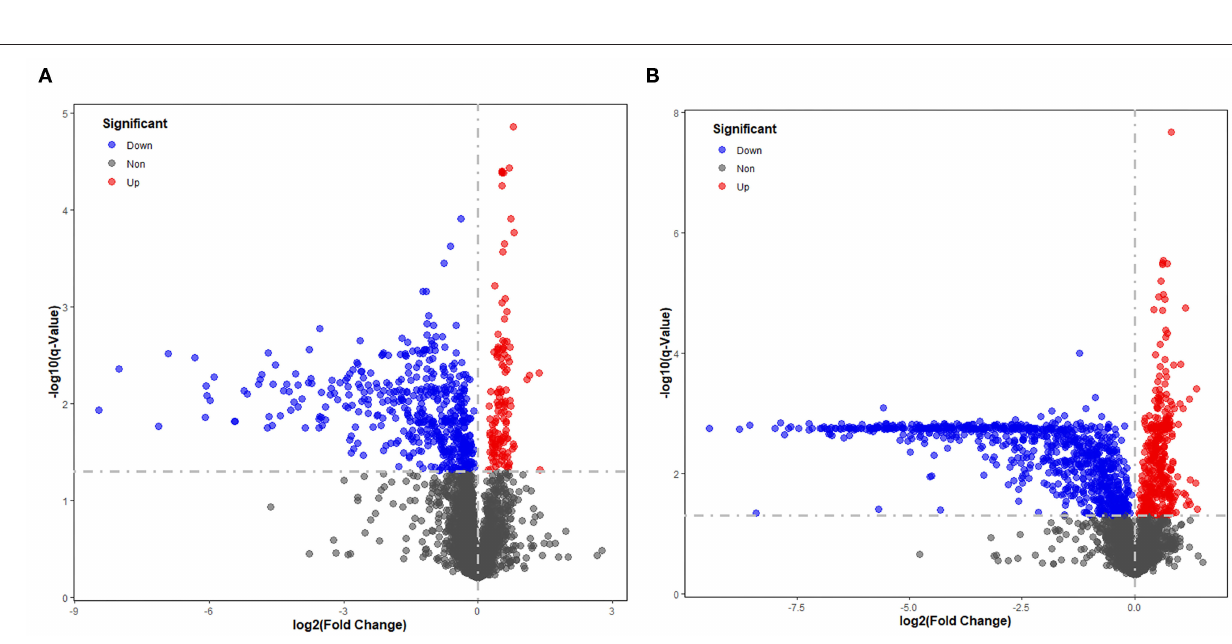
FIGURE 2 | Volcano plot representing the significant variables in the discrimination between AD and NAD groups in the negative mode (A) and positive (B) . The non-significant and the significant up-regulation and down-regulation variables are represented in gray, red, and blue [ q < 0.05 and fold change (AD/NAD) > 1]. VIP, variable importance in the